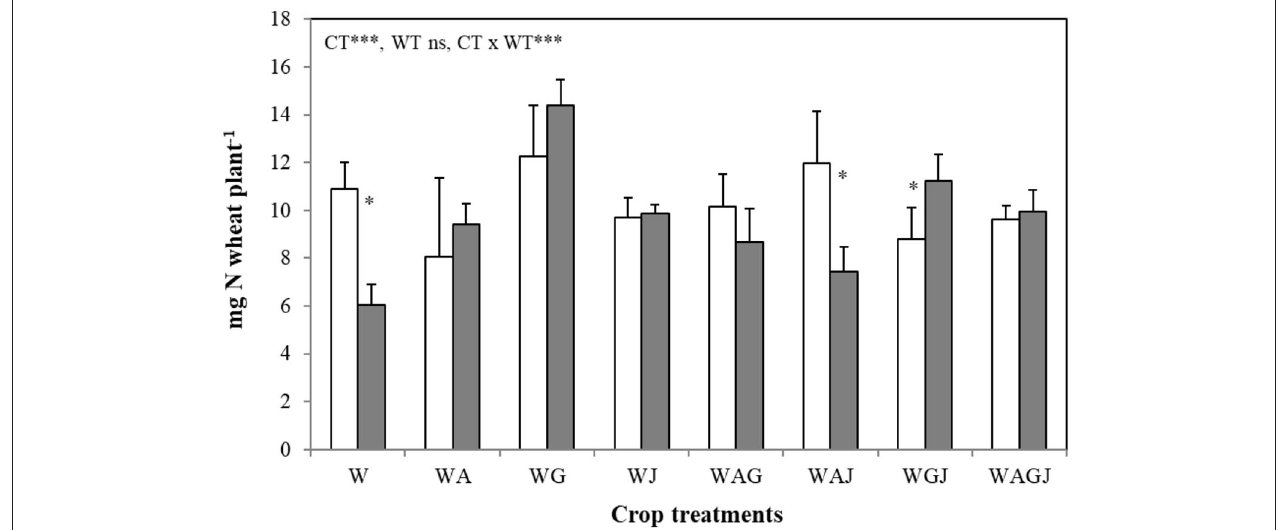
FIGURE 5 | Nitrogen content in shoots of spring wheat ( Triticum aestivum L. cv Dack) grown as a sole crop or intercropped with faba bean under adequate watering (80% field capacity; open bars) vs. water-stressed (30% field capacity, filled bars) conditions. Data are means and SE of three replicates harvested at 49 days post-transplantation. An asterisk * denotes a significant difference at p <